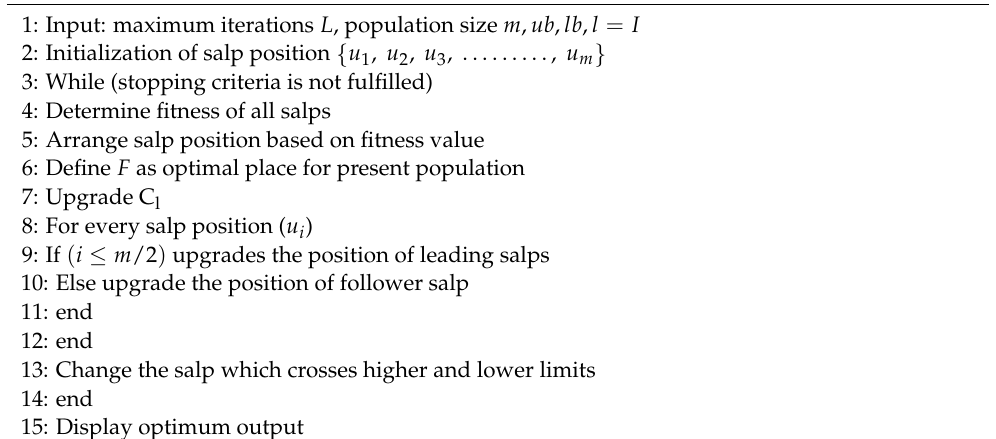
Algorithm 1 Pseudocode of